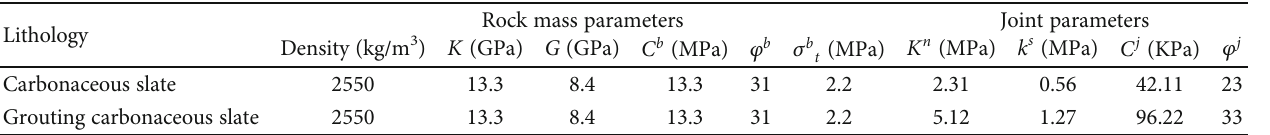
Figure 4: Numerical model of grouting geometric parameters. Table 2: Mechanical parameters.